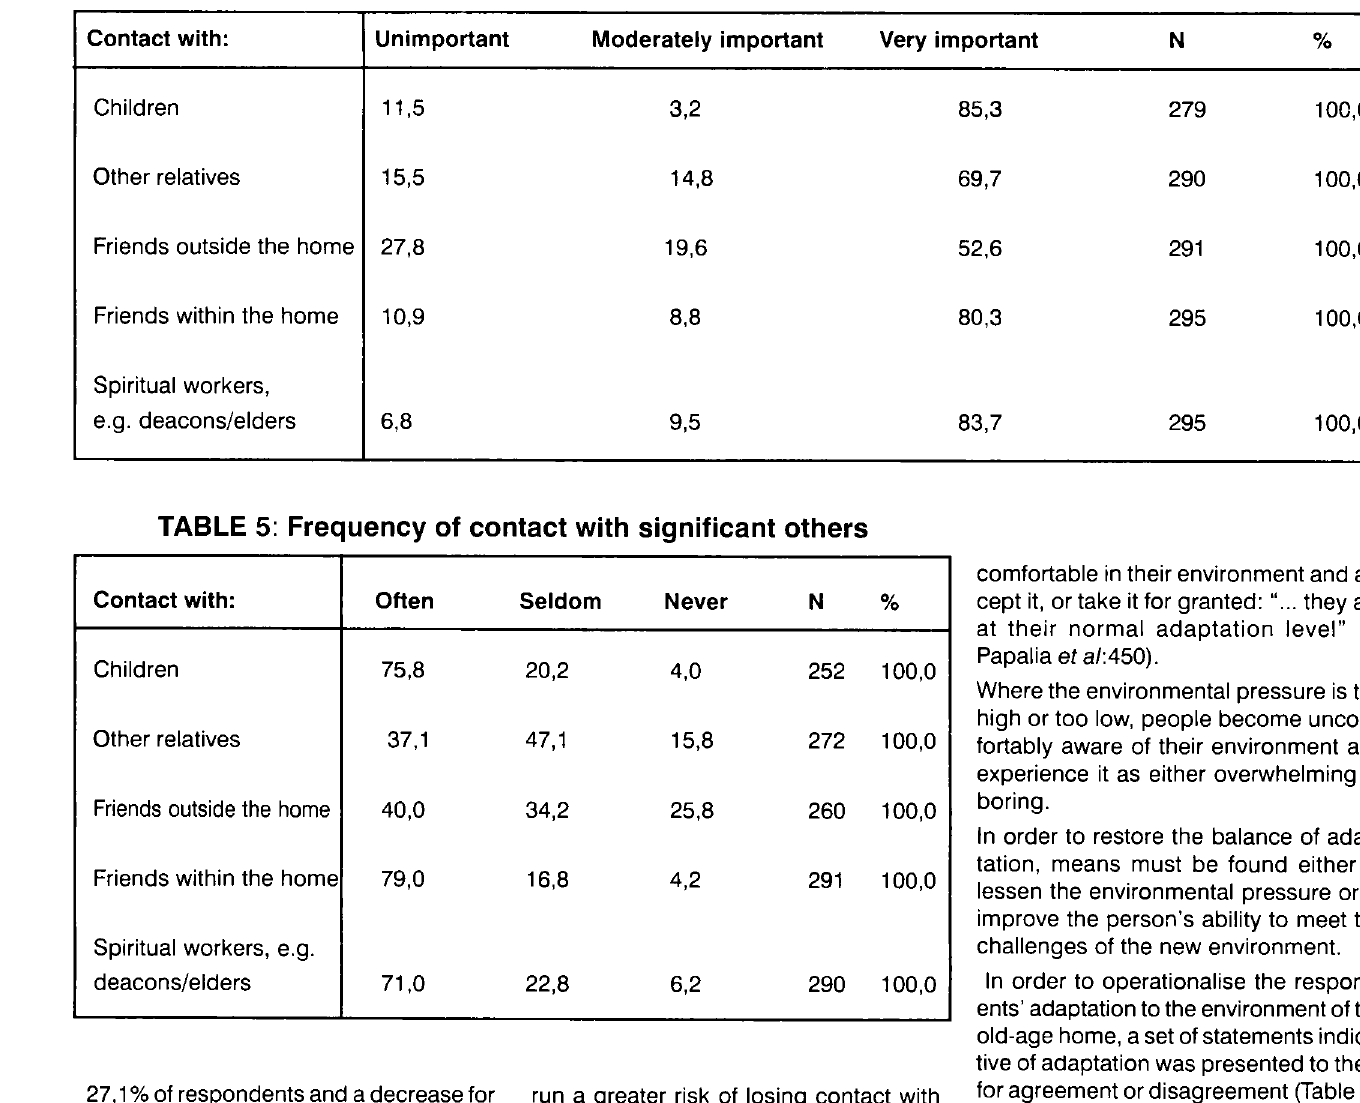
TABLE 4: The perceived importance of contact with significant others Contact with: